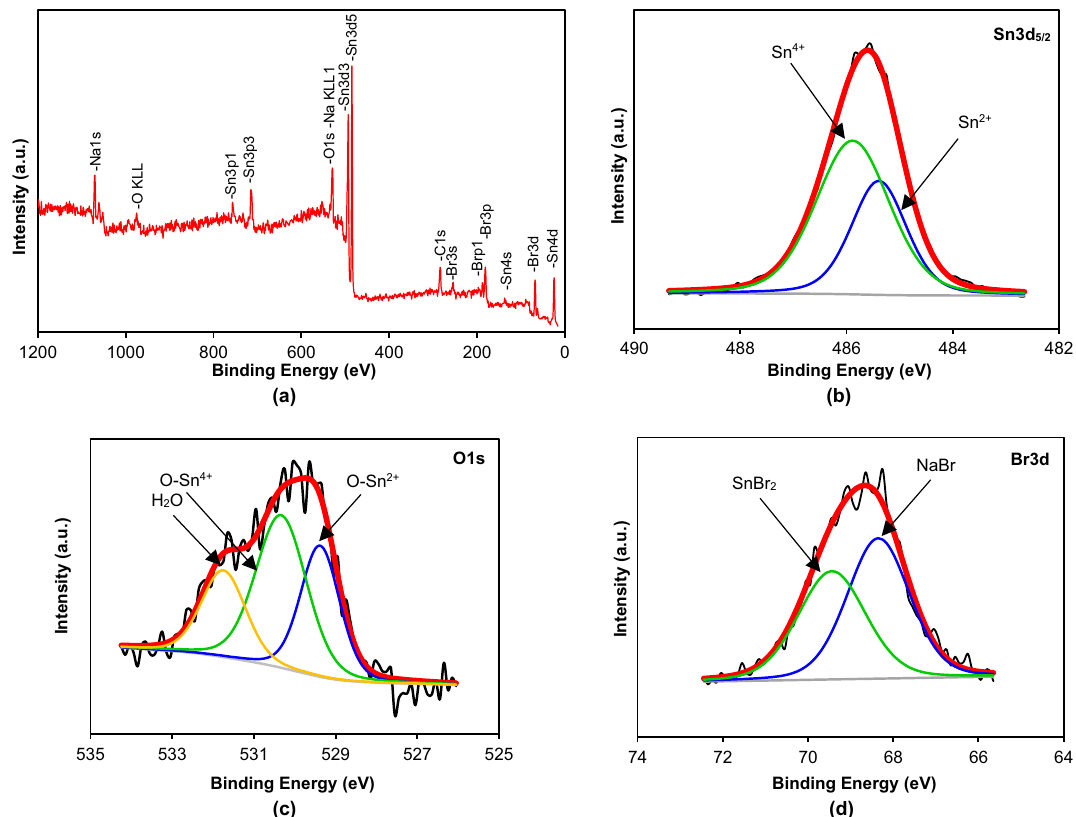
Figure 6. ( a ) XPS wide-scan spectrum; ( b ) XPS high resolution spectrum of Sn 3d 5/2 ; ( c ) O 1 s and ( d ) Br 3d of precipitate formed during the ECM test of tin in the presence of 0.5 M NaBr at a bias voltage of 3